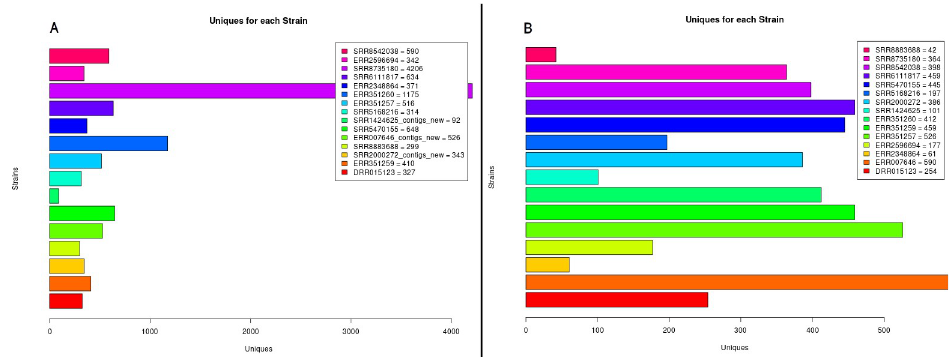
Fig 3. Unique genes for each strain. Graphs representing the number of unique genes identified in each species using PAN2HGENE (A) and PGAP (B) analyses.